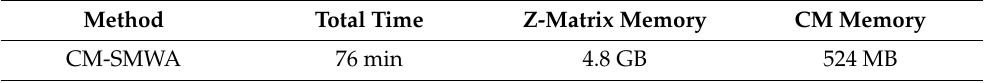
Table 6. Comparison of the CPU time and memory requirement of the different algorithms at 94